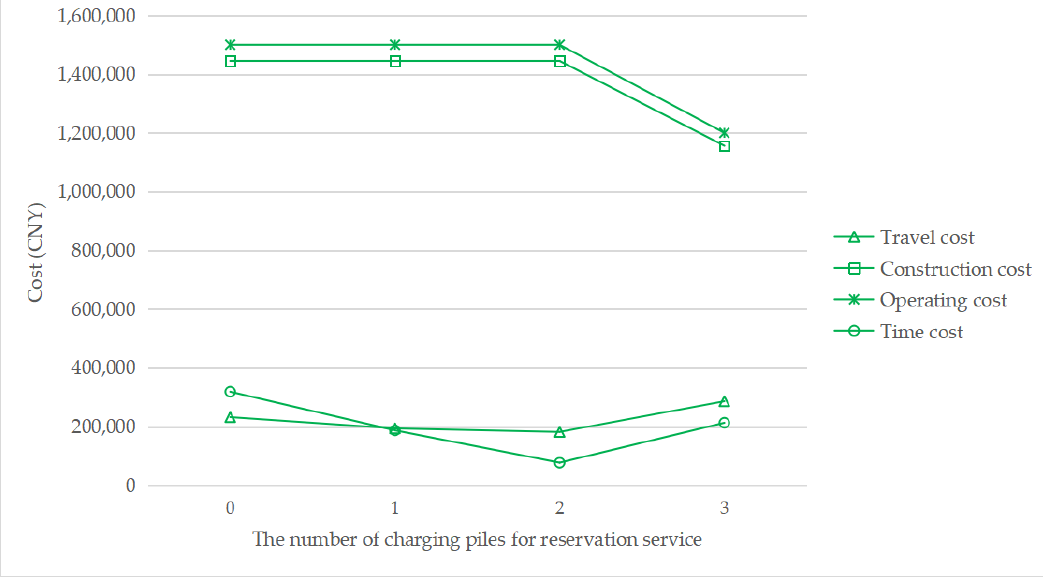
Figure 8. Cost change with a changing number of charging piles for the reservation service under τ = 1.0 .